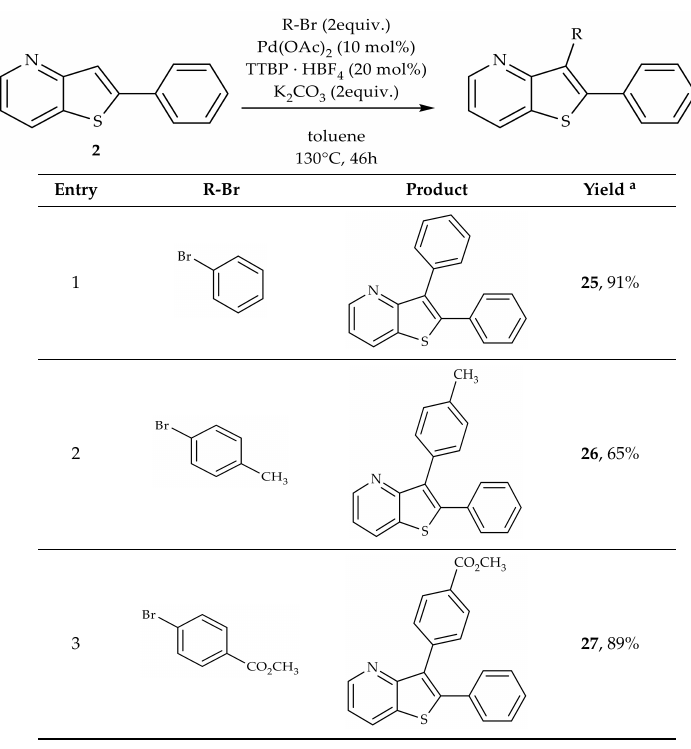
Table 7. Pd-catalyzed C–H arylation in position C-3 of the 2-phenylthieno[3,2- b ]pyridine 2